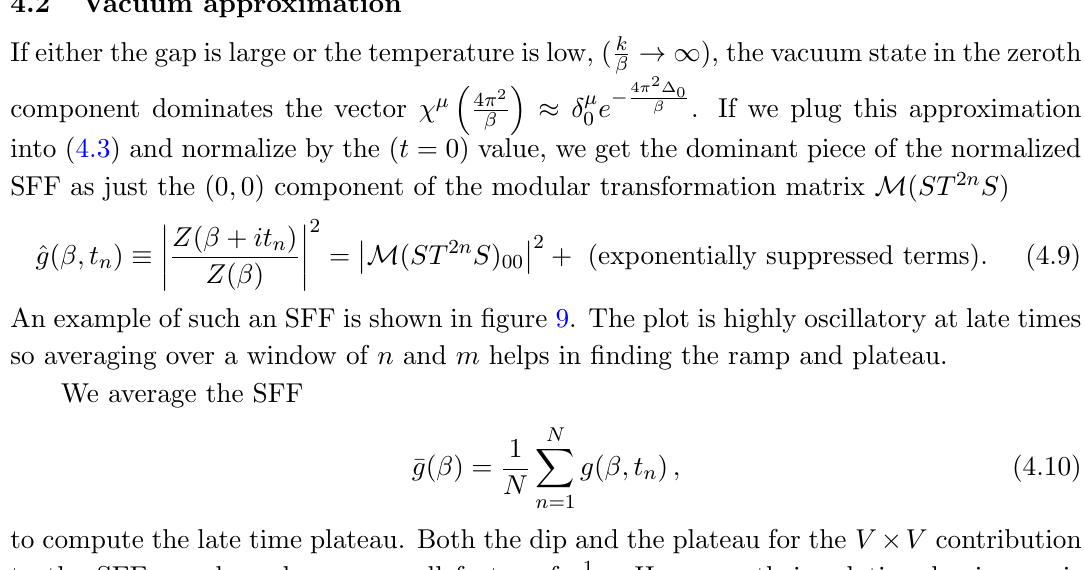
Figure 9 . The V (cid:2) V portion of the SFF of the m = 300 model. Upper left: the V (cid:2) V SFF before any averaging. Upper right: the V (cid:2) V SFF after averaging over a small window of 290 (cid:20) m (cid:20) 310. Lower left: the V (cid:2) V SFF of a single model m = 300, averaged over a log window of time. Lower right: the V (cid:2) V SFF with both m and time averaged. The data and error bars of the lower plots are the mean and the standard deviation of the mean over each time window. The log-log plot of the V (cid:2) V SFF (cid:12)ts well to inverse powers of log( n ), at intermediate and late